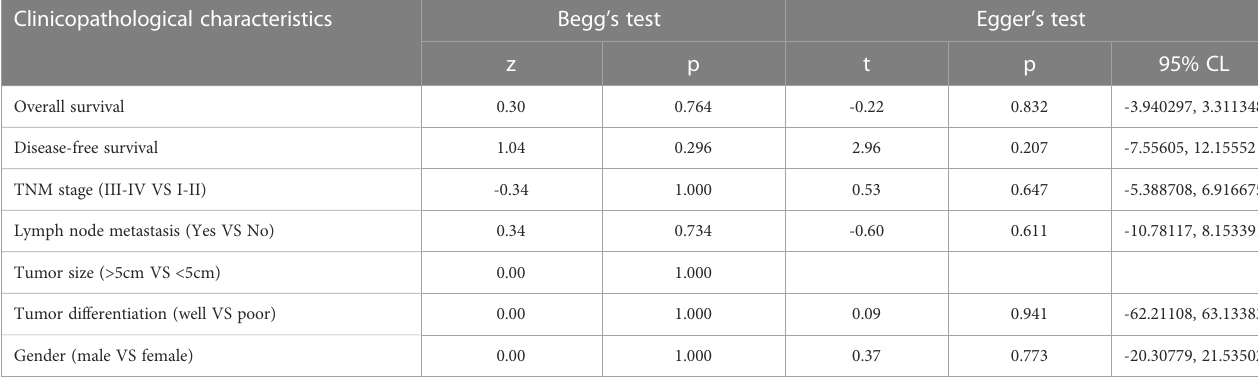
TABLE 5 Begg ’ s test and Egger ’ s